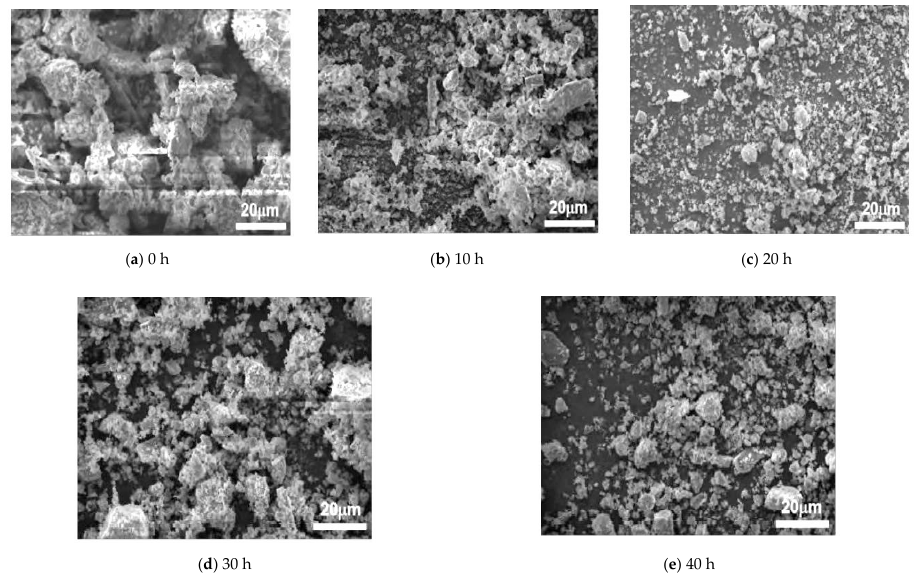
Figure 5. SEM photographs of recycled powder with different grinding times.